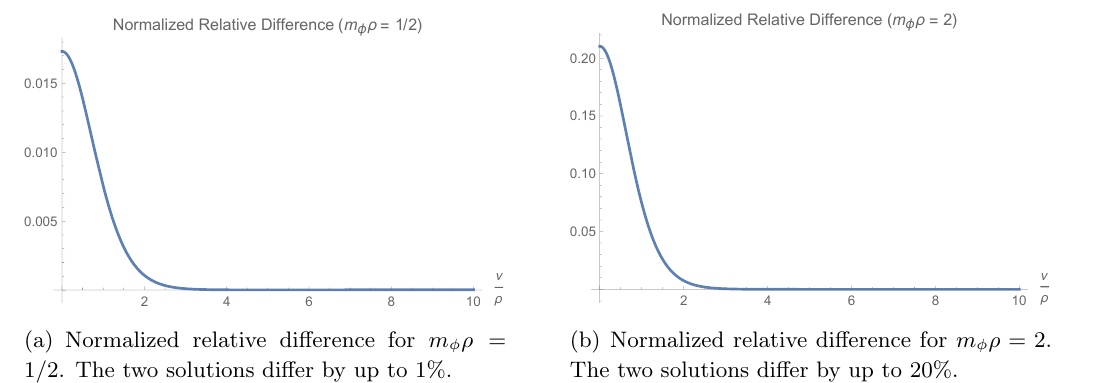
(b) Normalized relative di(cid:11)erence for m (cid:30) (cid:26) = 2. The two solutions di(cid:11)er by up to 20%. , where (cid:30) dBPS is the 1 2 ( (cid:30) ( (cid:23) )+ (cid:30) dBPS ( (cid:23) )) 0 limit indicate that if m (cid:30) (cid:26) . 1 #